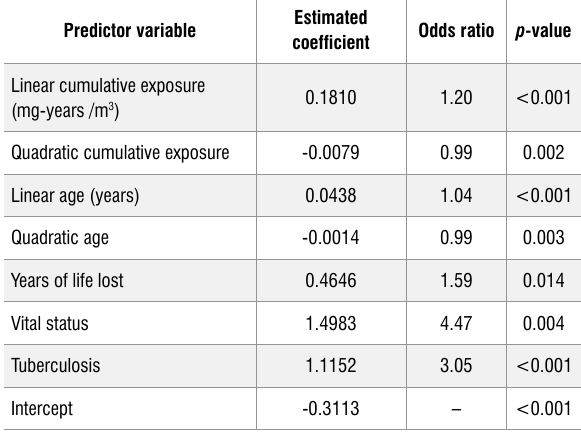
Final model to predict risk of silicosis a Predictor